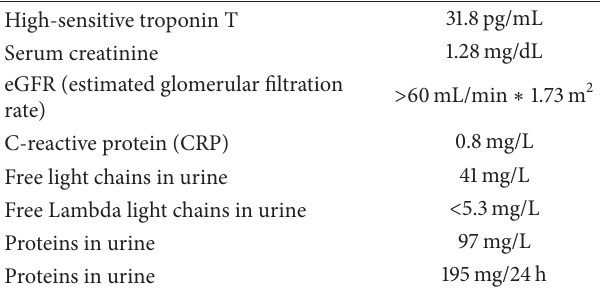
Table 1: Serum and urine laboratory